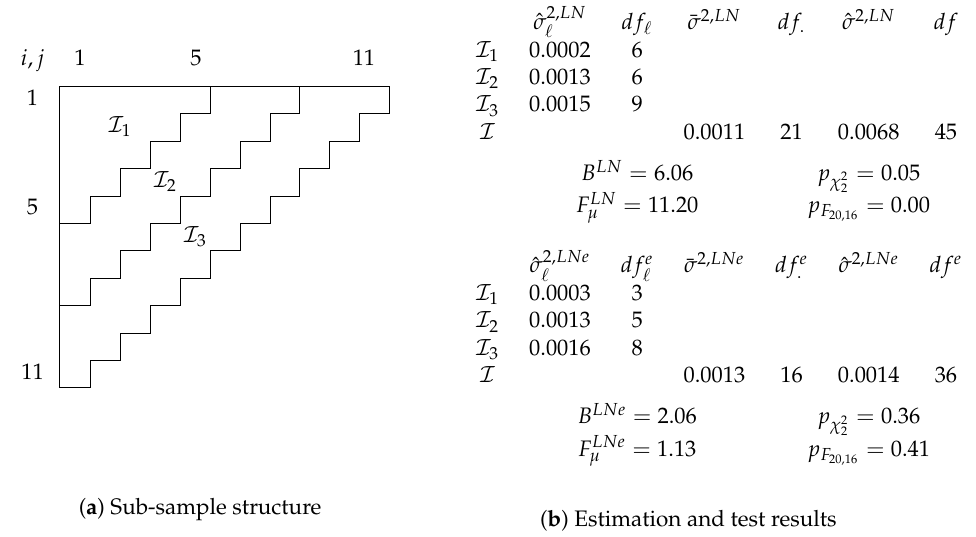
Figure 4. Log-normal chain-ladder ( LN ) and extended chain-ladder ( LNe ) model for Barnett and Zehnwirth (2000) data. Sub-sample structure shown in ( a ), estimation and test results in ( b